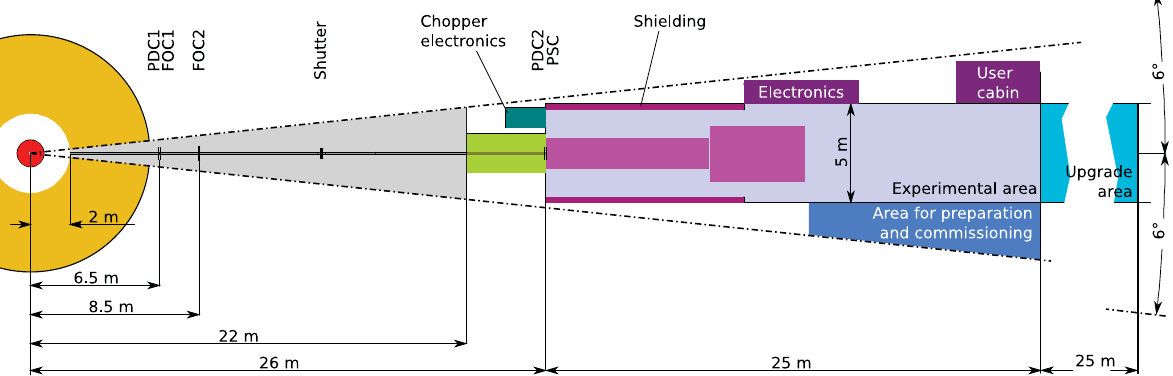
Figure 3. Proposed floor plan of the ANNI facility (schematic). Standard colors are as in Fig. 1. To give a scale, the magenta area indicates a PERC-like instrument with secondary spectrometer in measuring position. The upgrade area is needed for long experiments such as BeamEDM.